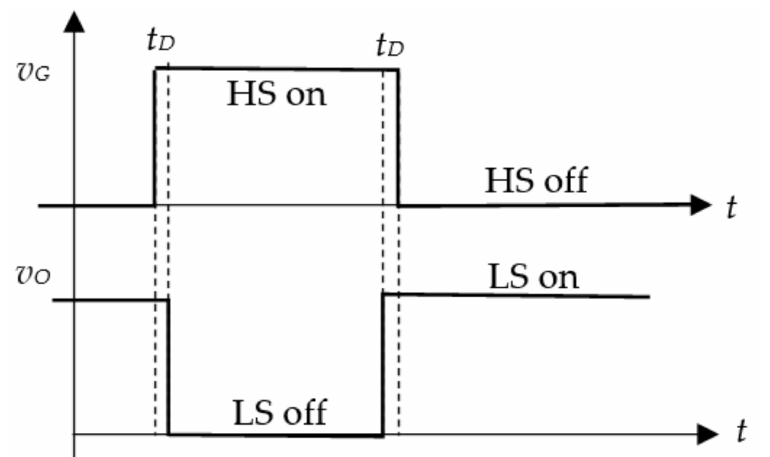
Figure 13. The conventional interlock switching to prevent the shooting-though